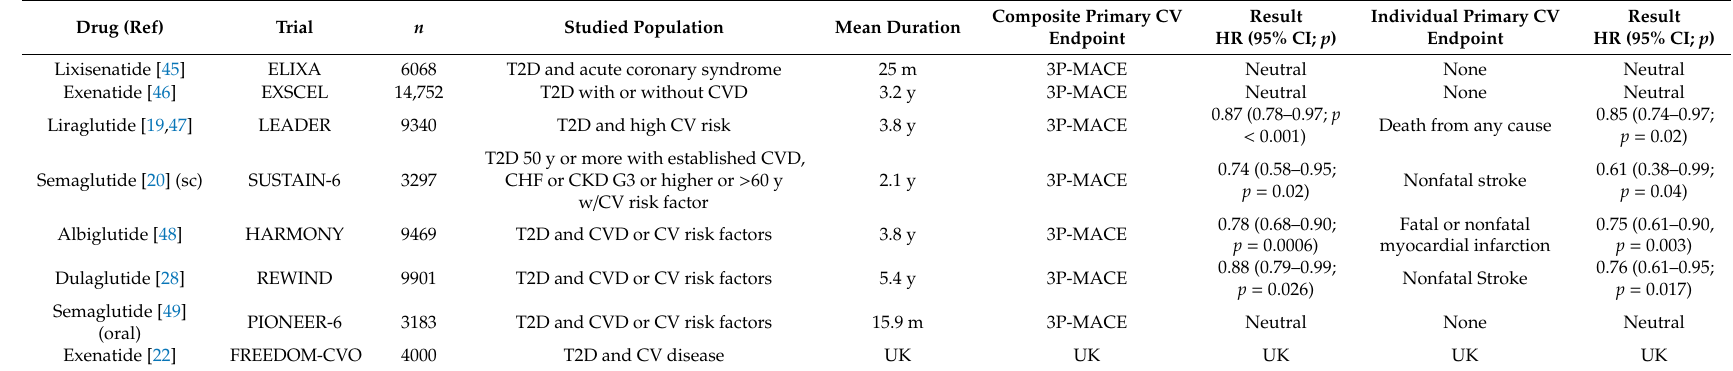
Table 2. Key GLP-1RA RCTs with cardiovascular and renal